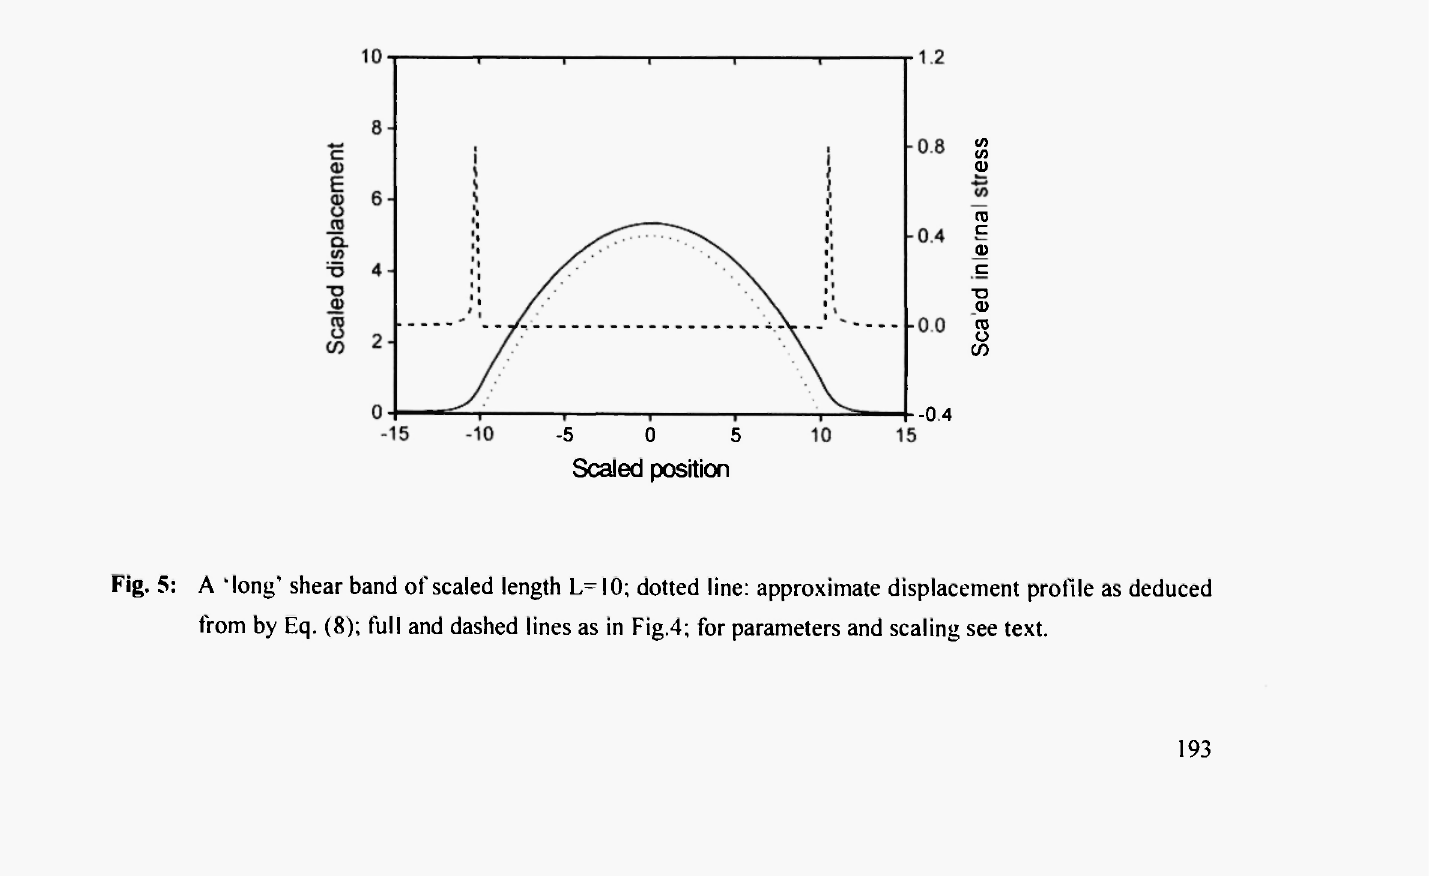
Fig. 5: A 'long' shear band of scaled length L=l0; dotted line: approximate displacement profile as deduced from by Eq. (8); full and dashed lines as in Fig.4; for parameters and scaling see